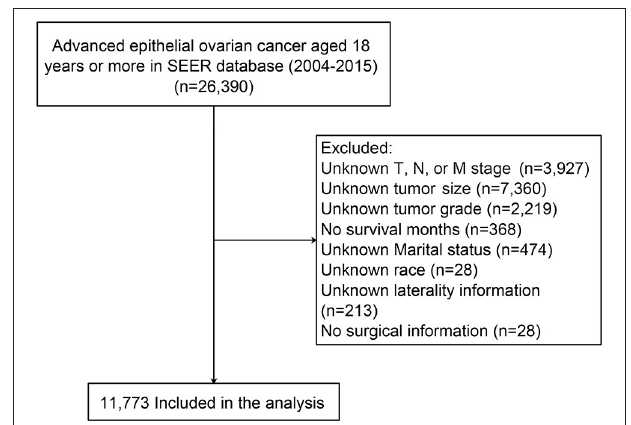
FIGURE 1 | Data selection